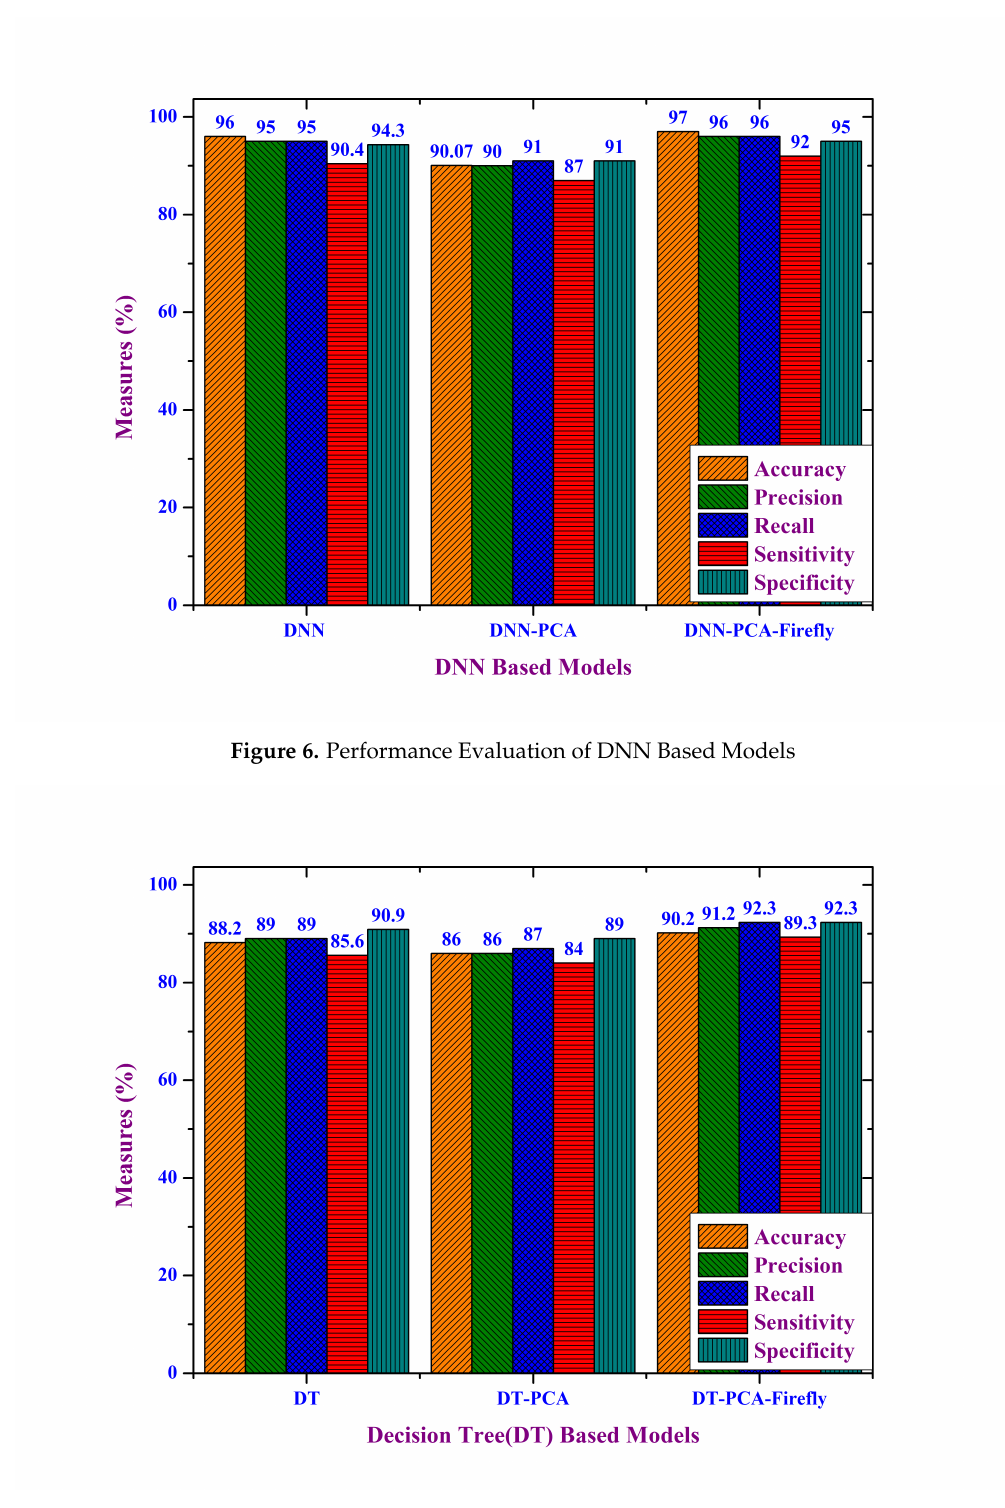
Figure 7. Performance Evaluation of Decision Tree Based